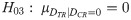
Empirical power of three difference tests.Statistical power of testing H01: ΔTC = 0 (dash), H02: ΔTR = 0 (dot), H03:μDTR|DCR=0=0 (solid) under four variation settings. Markers represent the simulation results, and the curves were generated as smooth lines by SAS procedure SGPLOT [12].